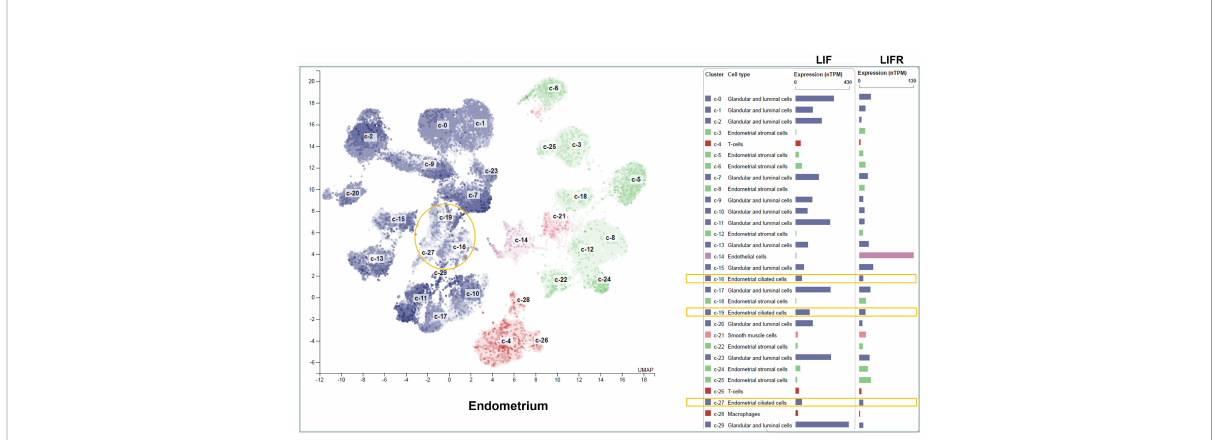
FIGURE 3 LIF and LIFR mRNA expression in different cell types of the human endometrium. The transcripts of LIF and LIFR in healthy human endometrial tissues are displayed at normalized expression levels (nTPM). Cell types in the endometrium include epithelial cells (blue), stromal fi broblasts (green), immune cells (red), vascular endothelium (purple), and vascular smooth muscle cells (orange). The epithelial cells are further divided into luminal epithelium, glandular epithelium and ciliated epithelial cells. The ciliated epithelial cell clusters are highlighted in yellow boxes. Figure is available from The Human Protein Atlas website (accessed on August 15,